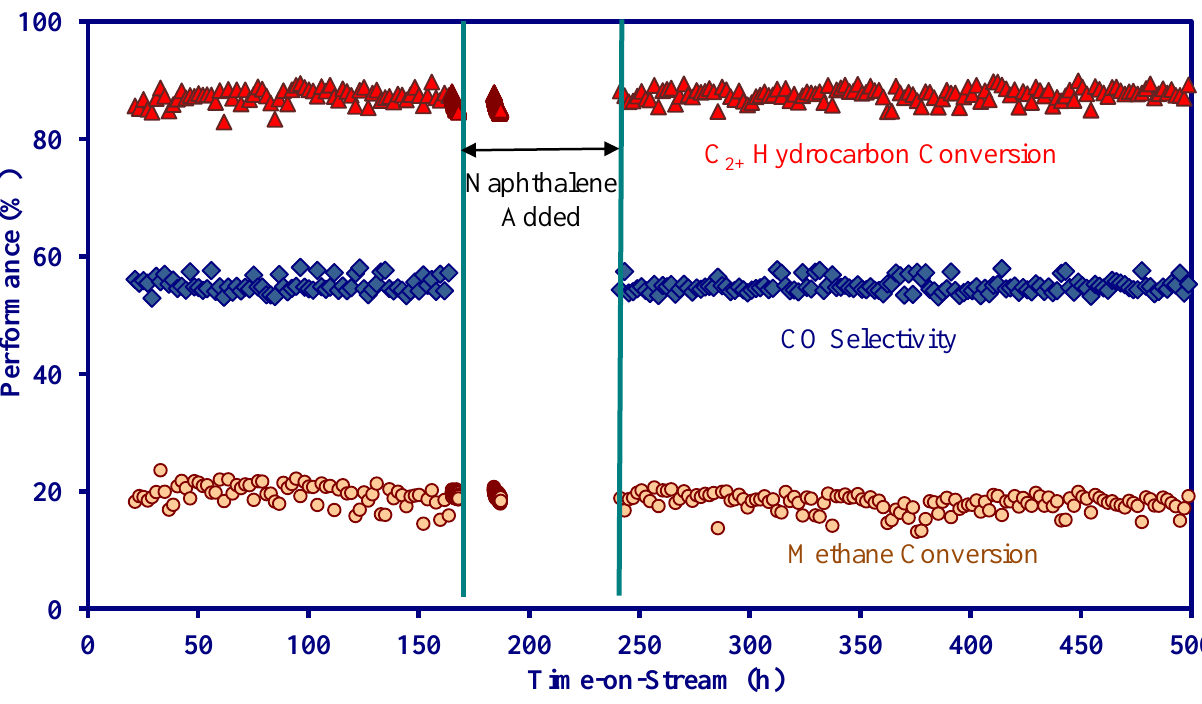
S under the conditions of 900 °C, GHSV = 10,000 h −1 , 2 , 5.8% CH , 13.2% N , 44.6% H O, 1.6% C H and C H 2 4 2 2 2 6 2 4